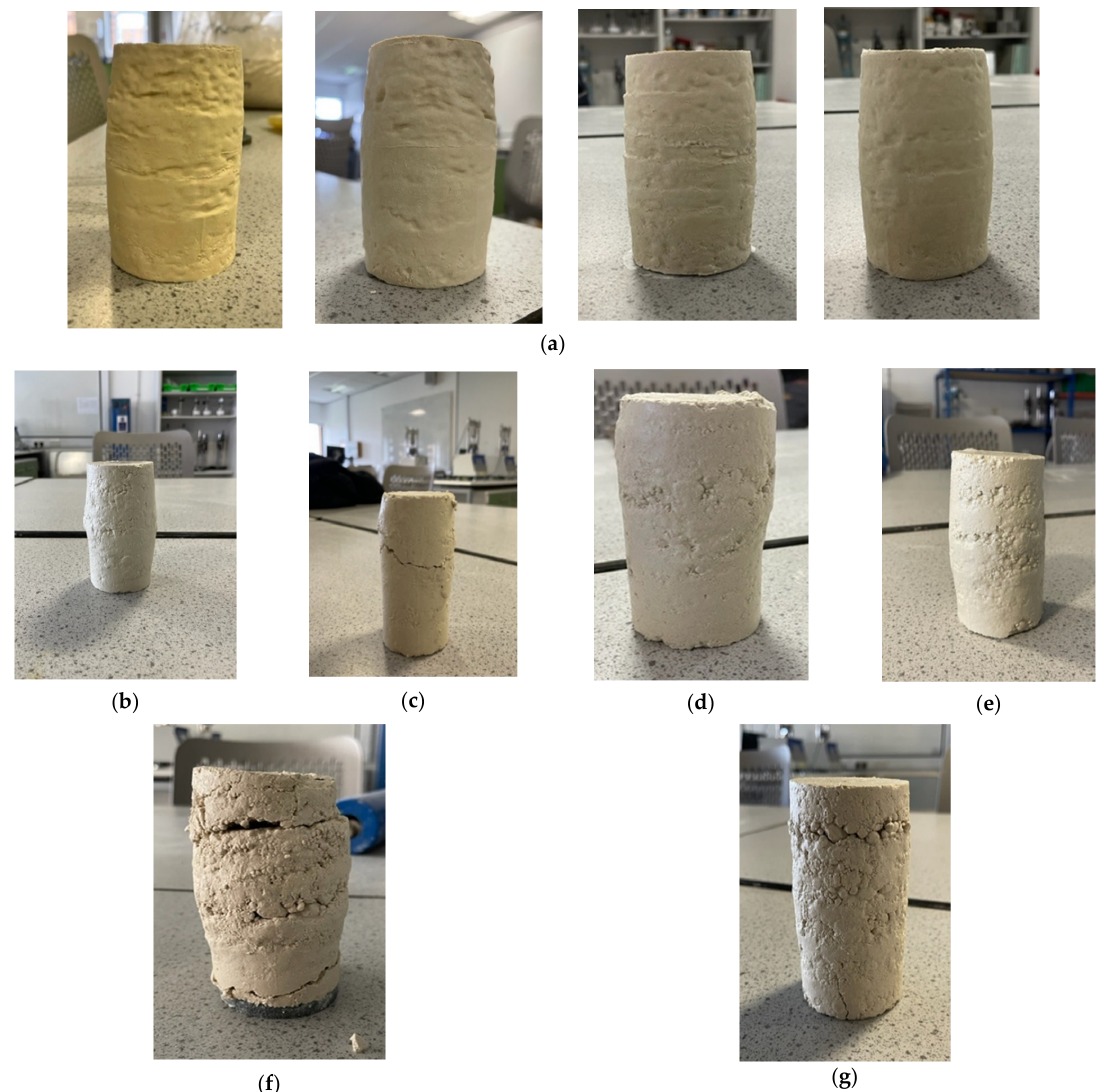
Figure 7. Behaviour of samples at failure: ( a ) unstabilised soils; ( b ) stabilised soils with 10% gypsum under 100 kPa constant effective pressure; ( c ) stabilised soils with 10% gypsum under 200 kPa constant effective pressure; ( d ) stabilised soils with 20% gypsum under 100 kPa constant effective pressure; ( e ) stabilised soils with 20% gypsum under 200 kPa constant effective pressure; ( f ) stabilised soils with 30% gypsum under 100 kPa constant effective pressure; ( g ) stabilised soils with 30% gypsum under 200 kPa constant effective pressure.